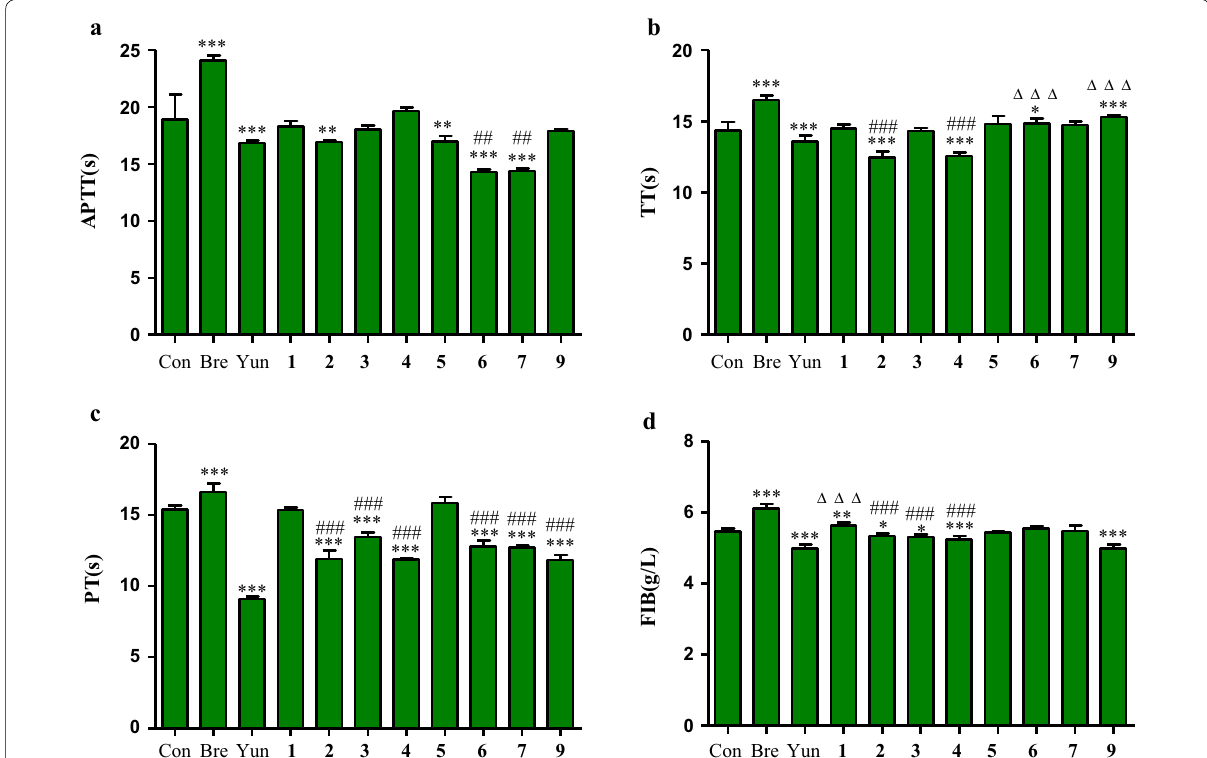
Fig. 2 Effects of compounds 1–7 and 9 on plasma coagulation parameters in vitro ( a APPT; b PT; c TT; d FIB. n (Con), *** p < 0.001 < ** p < 0.01 < * p < 0.05; Compared with Yunnan Baiyao (Yun), ### p < 0.001 < ## p < 0.01 < # p < 0.05; Compared with breviscapine (Bre), △△△ p < 0.001 < △△ p < 0.01 < △ p <